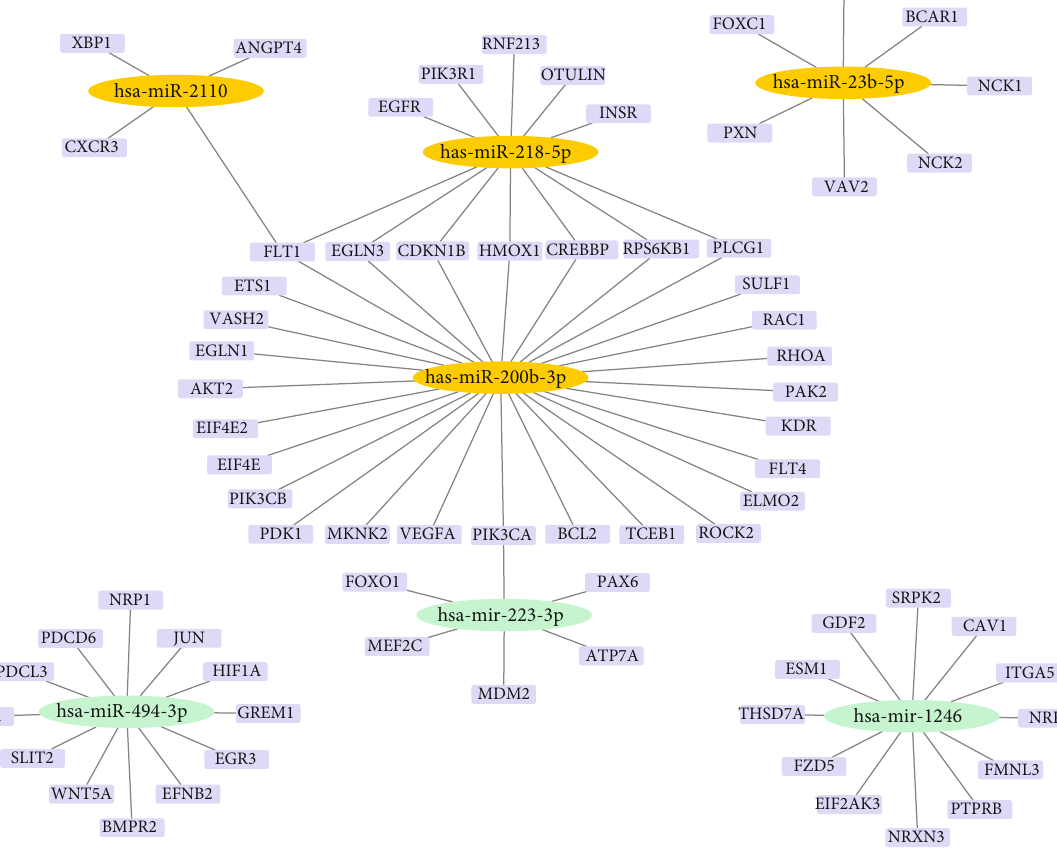
Figure 8: The regulatory networks of microRNAs and angiogenesis-related target